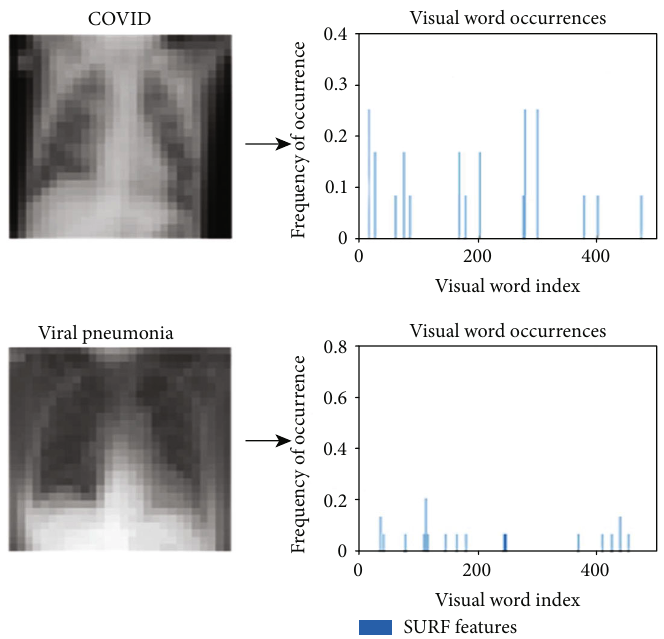
Figure 5: The visual encoded features of the X-ray images for COVID-19 and pneumonia